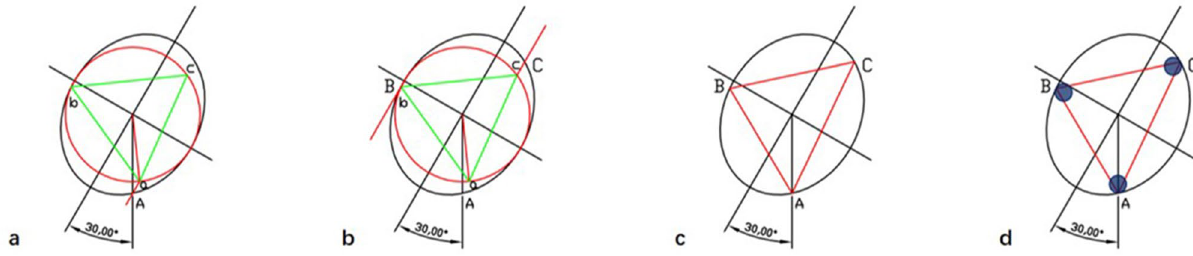
Figure 1. An oblique ellipse model was established based on the morphological features of the cross-section of the femoral neck isthmus. The screws on the ellipse were based on the cortex support of the femoral neck. An oblique triangle was drawn on the ellipse according to the method of inscribed triangles with the largest area of the ellipse. The predicted insertion of the femoral calcar screw is defined as point A, which is implanted at the bottom of the femoral neck cavity on anteroposterior X-ray and the centerline of the femoral neck on lateral X-ray. The oblique triangle was drawn as follows: ( a ) Point A was determined by the intersection of the vertical lines through the ellipse center and the ellipse, which was the position of the first screw in the OTC method. A line was drawn parallel to the long axis of the ellipse through point A and the intersection of the line and the inscribed circle was defined as point a. The largest inscribed triangle (isosceles triangle) of the circle was made with point a as the vertex, and the other two vertices were then defined as point b and point c. ( b ) Two lines through points b and c were drawn parallel to the long axis of the ellipse, and the intersection points of the two lines and ellipse were set as the position of the screws (points B and C). ( c ) The triangle was formed by three points of A, B, C, which was the inscribed triangle (oblique triangle) with the largest area. ( d ) Screws position in oblique triangle configuration (blue